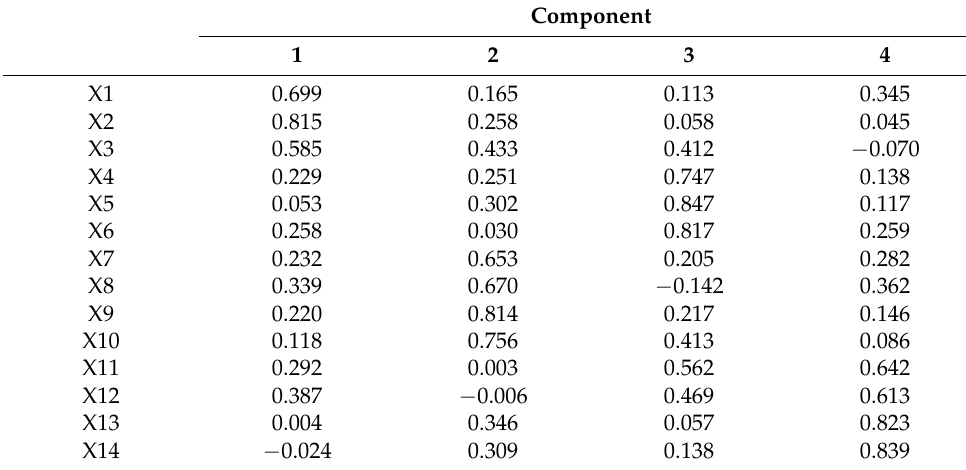
Table 3. Rotation component